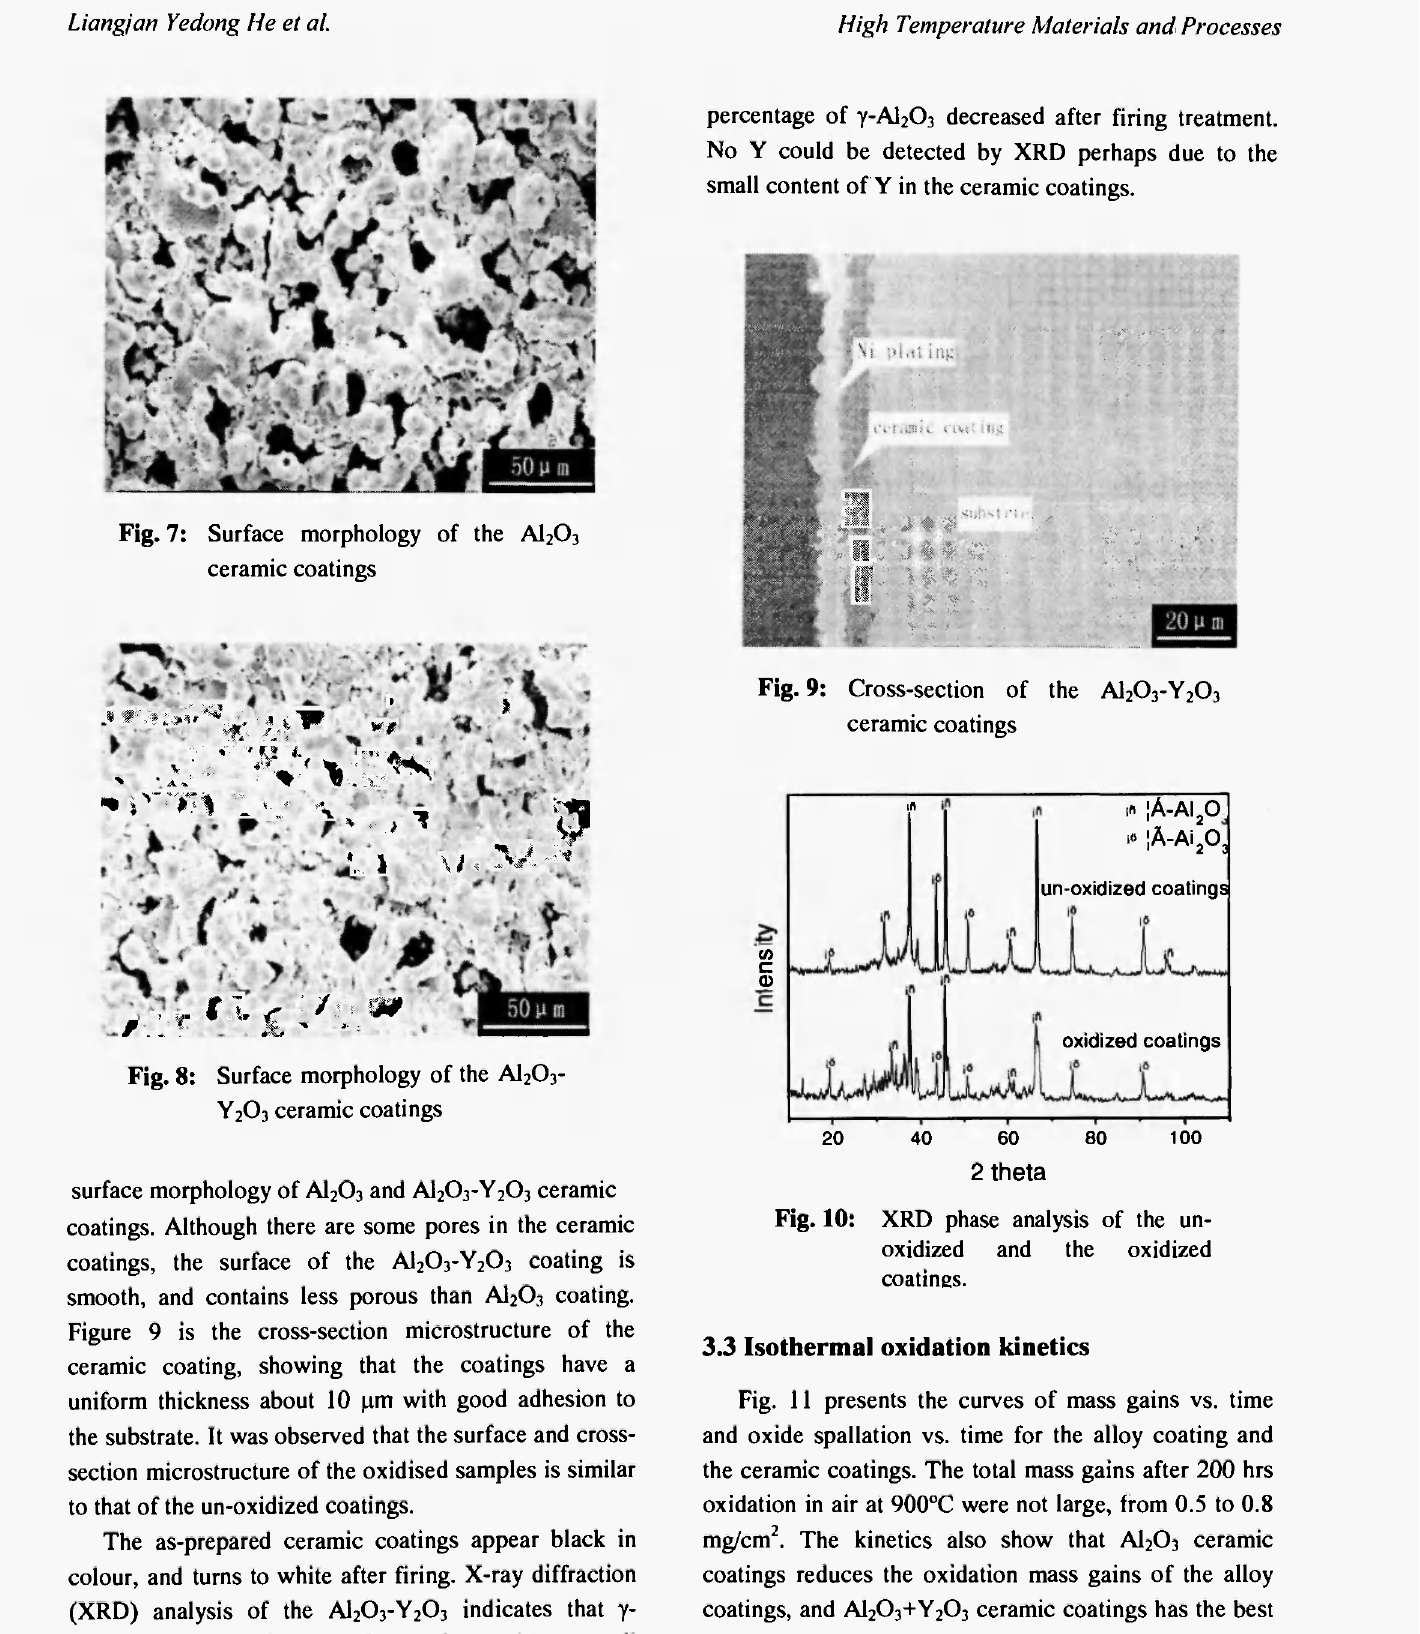
Fig. 10: XRD phase analysis of the un- oxidized and the oxidized